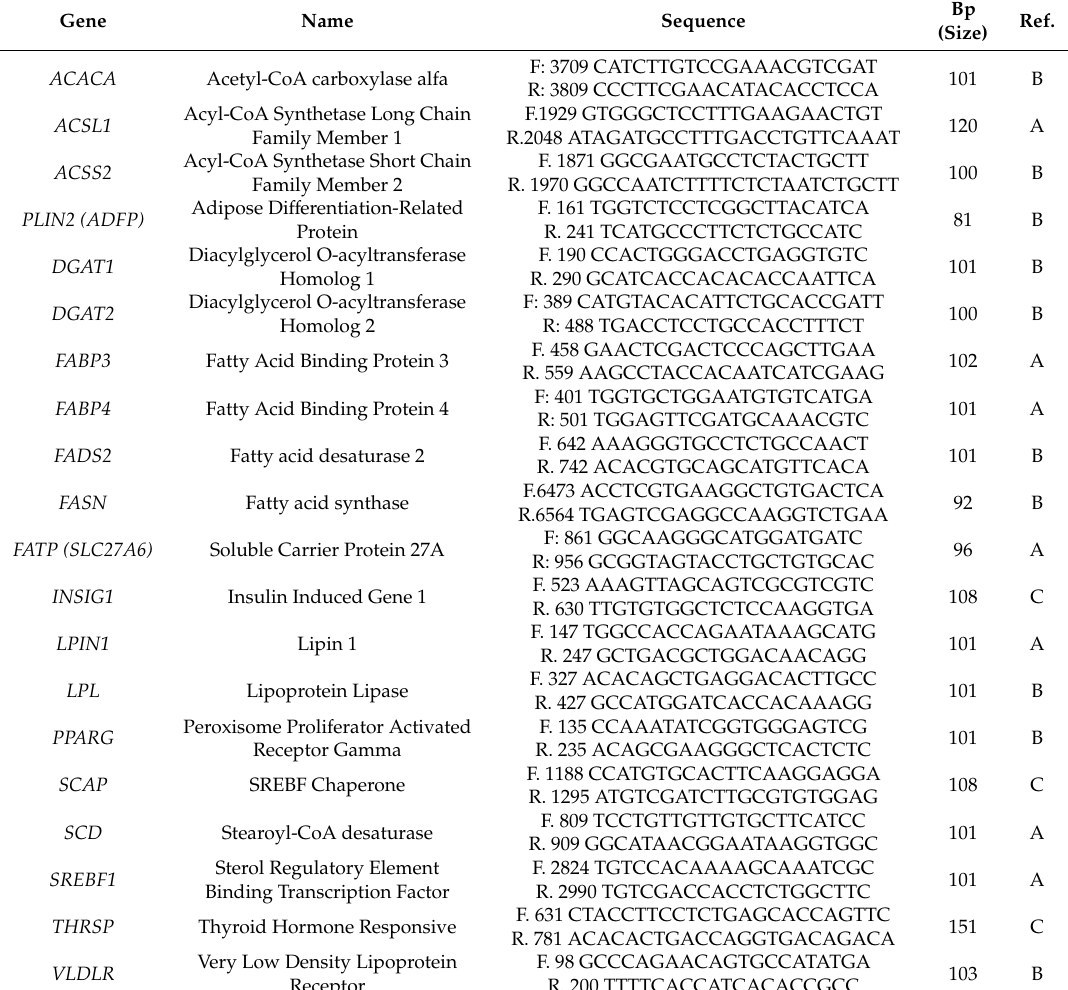
Table 2. Gene symbol, name, sequence and size of the 20 genes measured in milk somatic